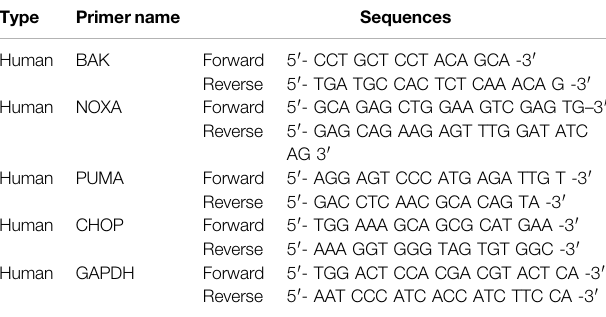
TABLE 2 | RT-qPCR primer sequences